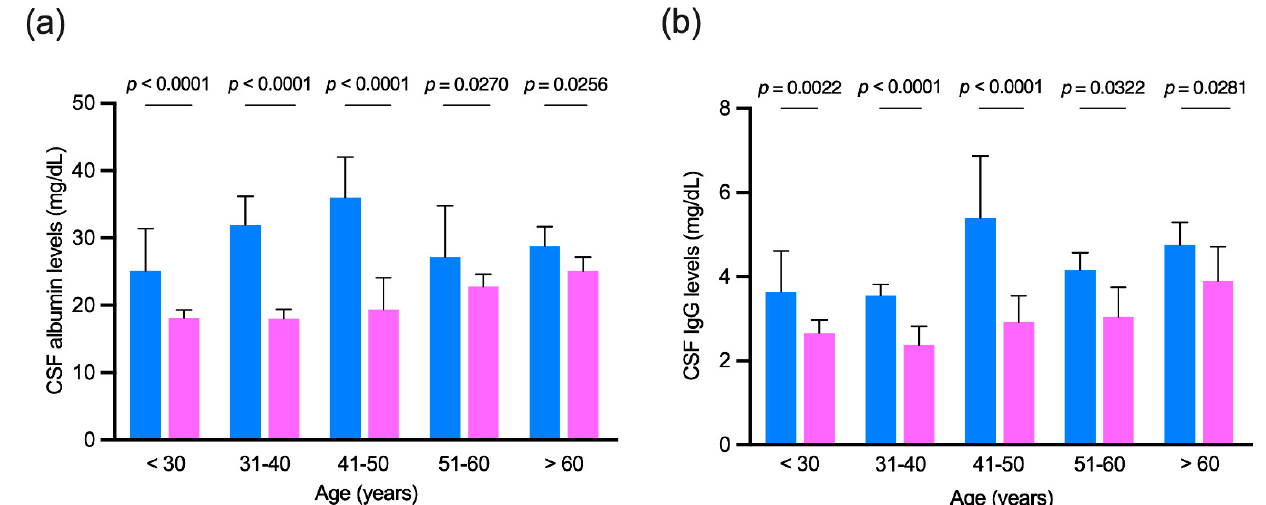
Figure 2. ( a ) Cerebrospinal fluid (CSF) albumin and ( b ) IgG levels in patients negative for the presence of intrathecal IgG synthesis grouped by age. Light blue, men; pink, women. Mann–Whitney test was used for all comparisons. Bars represent medians and 95% confidence intervals. Table 3. Cerebrospinal fluid (CSF) albumin and IgG levels were compared in women and in men negative for the presence of an intrathecal IgG synthesis with Quade statistics adjusting for age at lumbar puncture, and serum albumin or serum IgG levels.